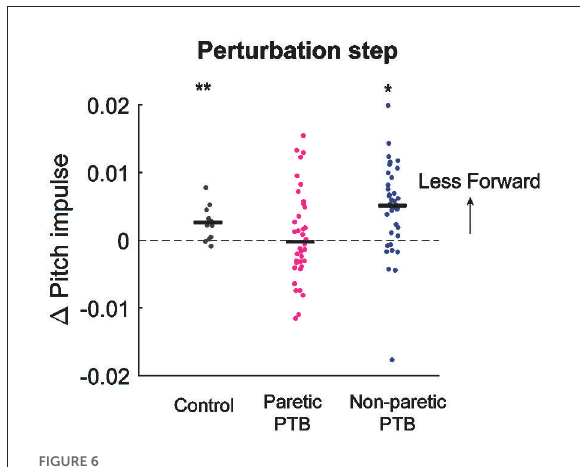
FIGURE6 Median changes in pitch impulse following perturbations compared to those measured during the pre-perturbation step for control participants (Gray, N 13) and during paretic (Pink) = and non-paretic (Blue) steps for stroke participants (N 38). = Each dot represents one participant. Black horizontal lines indicate the median across participants. Positive values indicate less forward pitch impulse. The asterisks (*) indicate whether the group mean is significantly different from zero (*p < 0.05, **p < 0.001).